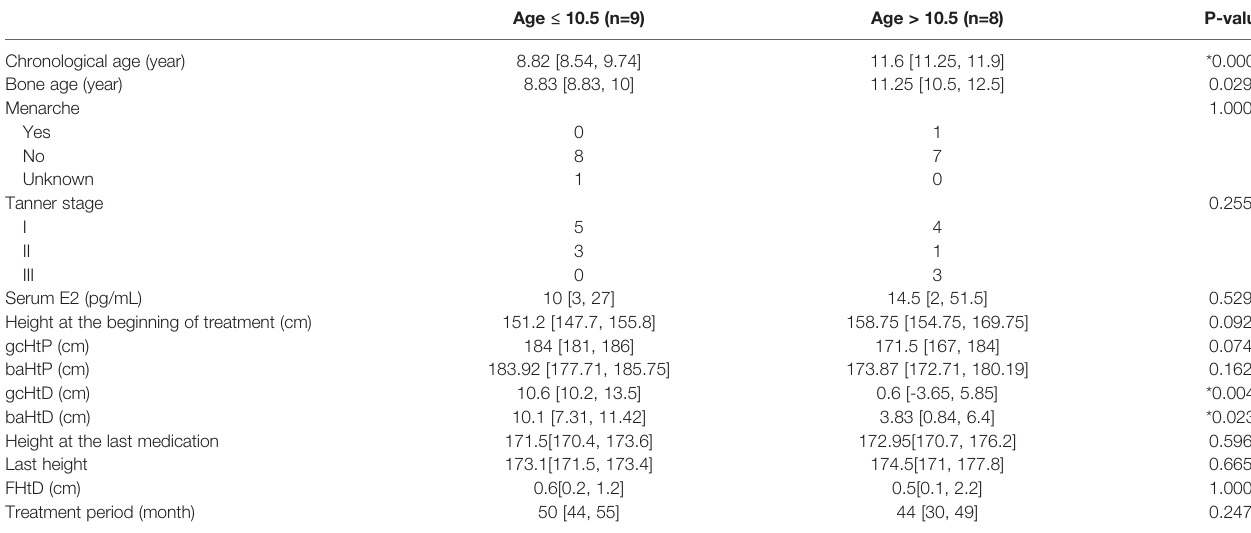
TABLE 1 | Comparison of baseline characteristics of two groups divided by